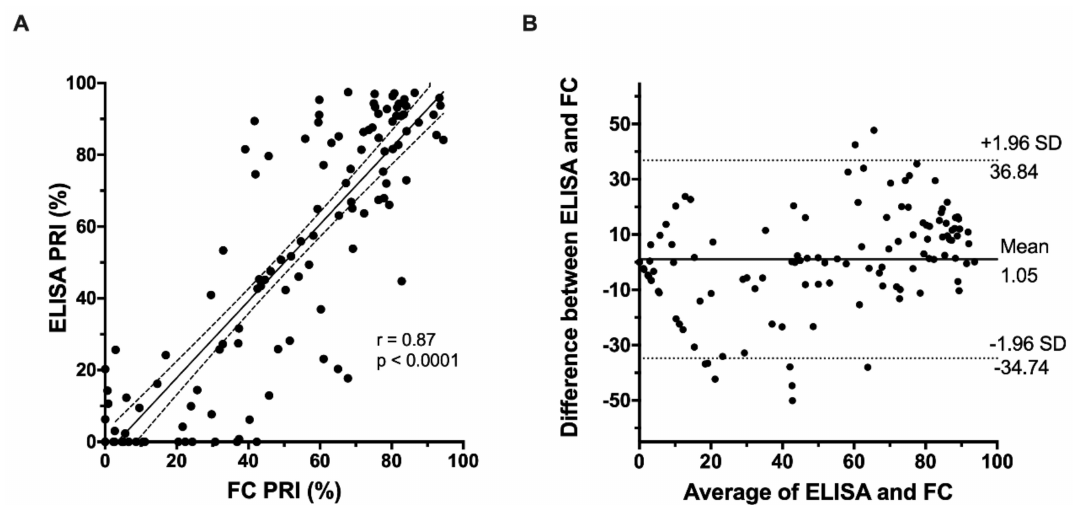
Figure 2. Correlation of FC-VASP with ELISA-VASP ( A ) Linear regression between ELISA-based and flow cytometry-based VASP phosphorylation assessment. ( B ) Bland–Altman assessment of agreement between ELISA-based and flow cytometry-based VASP phosphorylation assessment. PRI: platelet reactivity